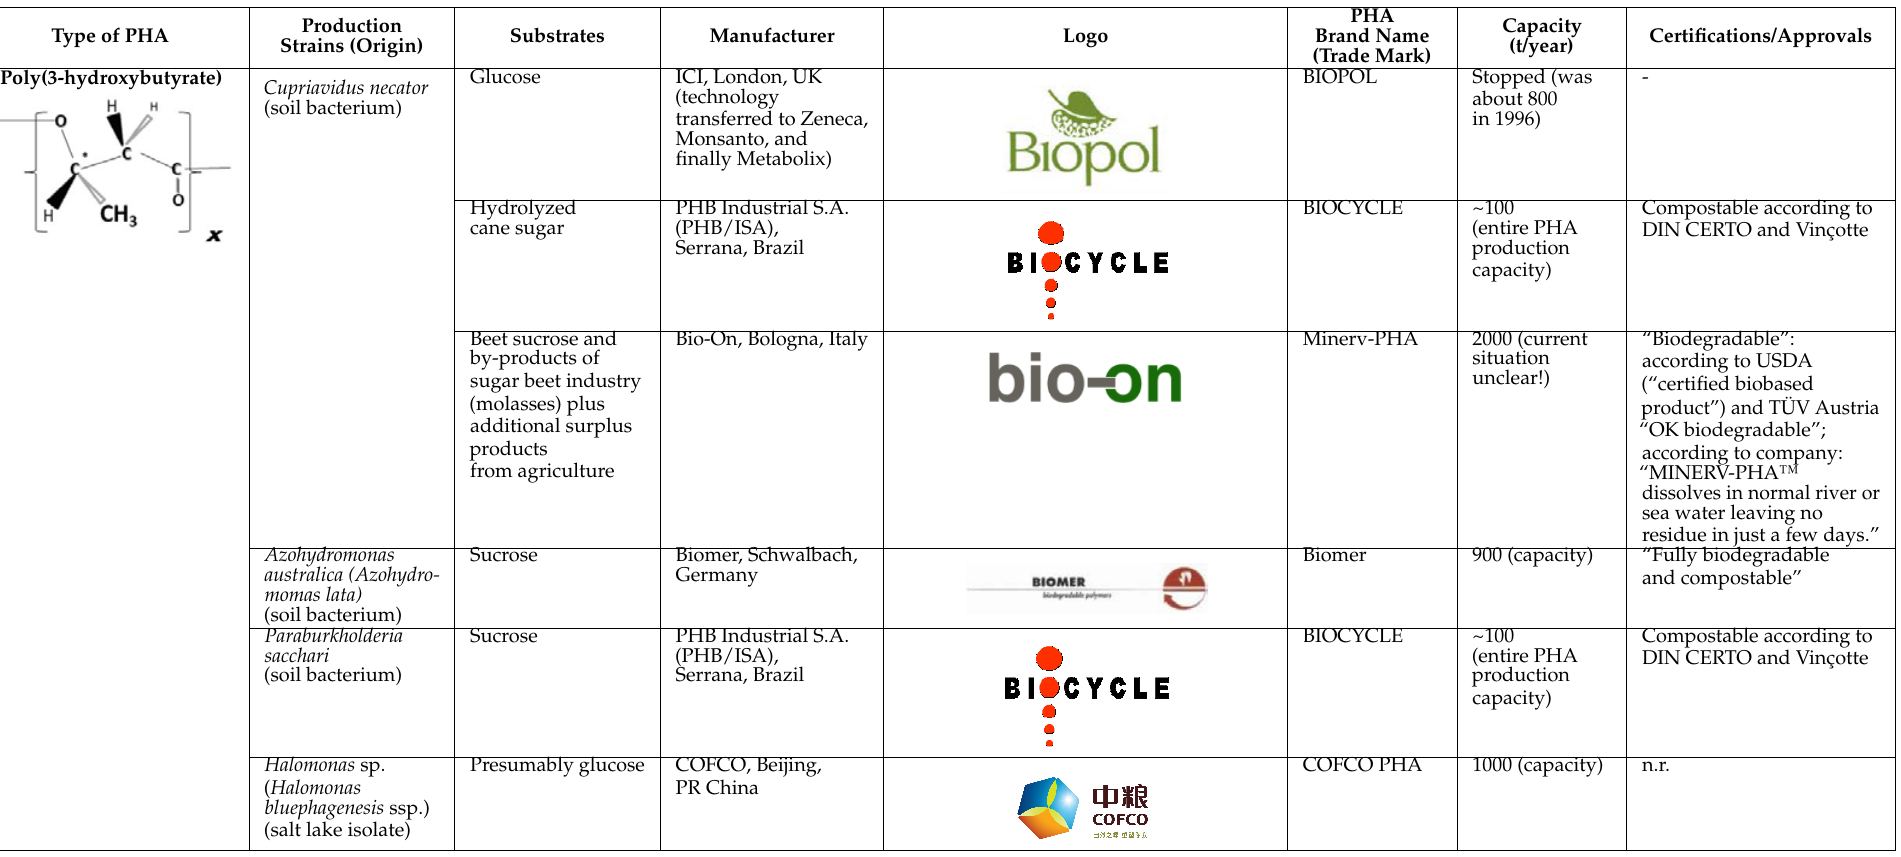
Table 1. Most commercialized types of PHA (P(3HB), P(3HB- co -3HV), P(3HB- co -4HB), P(3HB- co -3HHx), P(4HB)), production strains, substrates, manufacturers, manufacturing scale/capacity, and